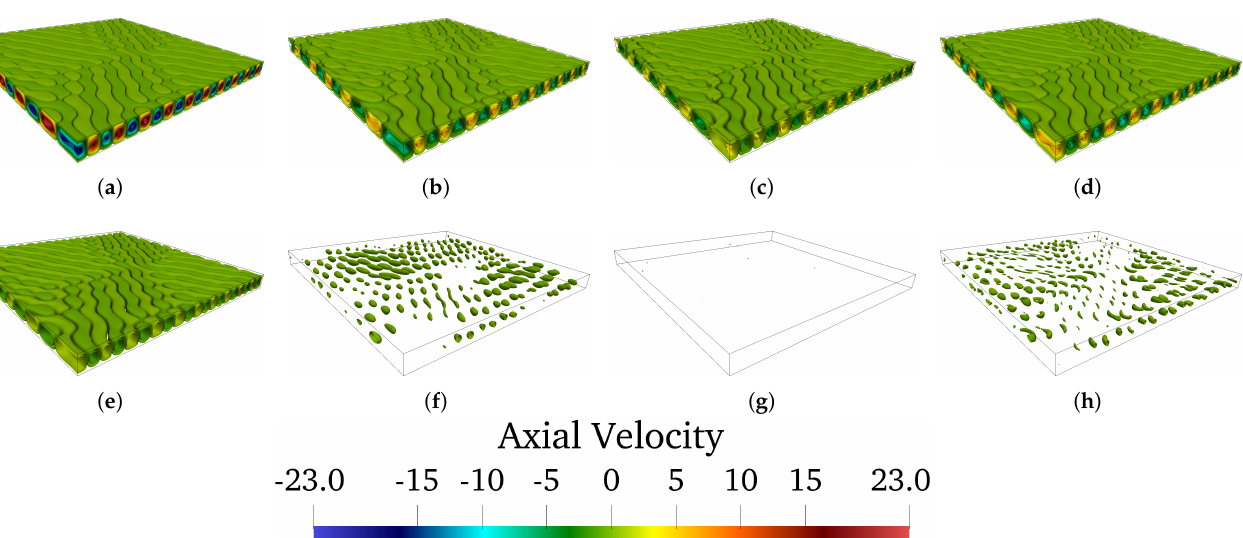
Figure 3. Angular frequency of the Axial velocity signal (probe being located in the center of the layer). Numerical simulation with AR = 15, Pr g = 8, Ω = 25, ξ = 0.5, ϑ = 0.1, and Ra ω = 4000. ( a ) Sinusoidal and ( b ) Pulse waves.